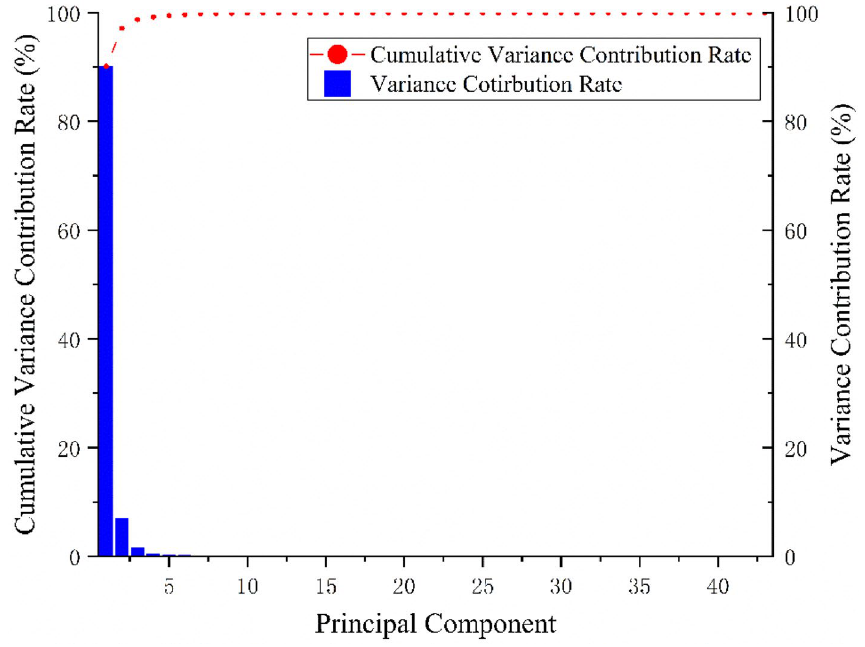
Figure 2. Variance contribution of the principal